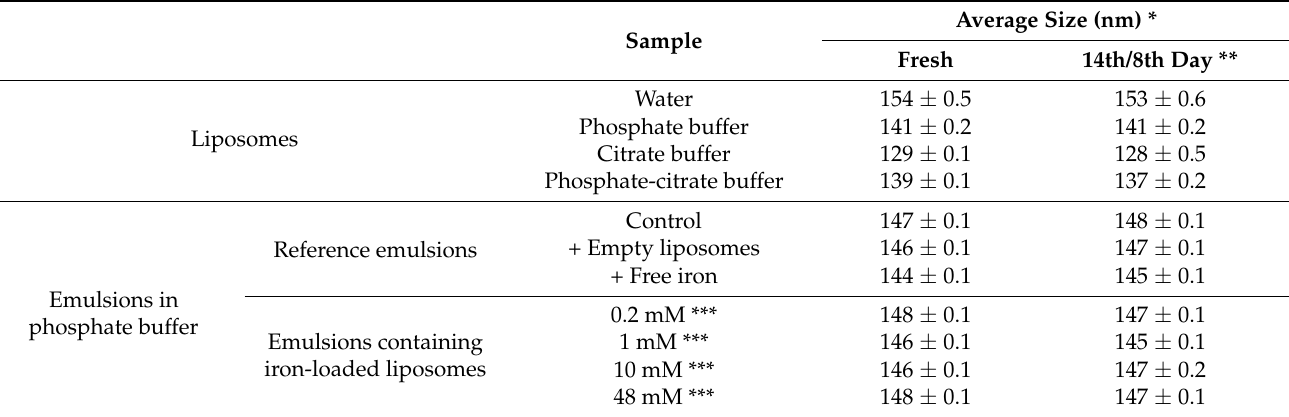
Table 2. Size of iron-loaded liposomes, and of O/W emulsion droplets. Reported values are the average ± standard deviation of the nine measurements done for two independently prepared batches.